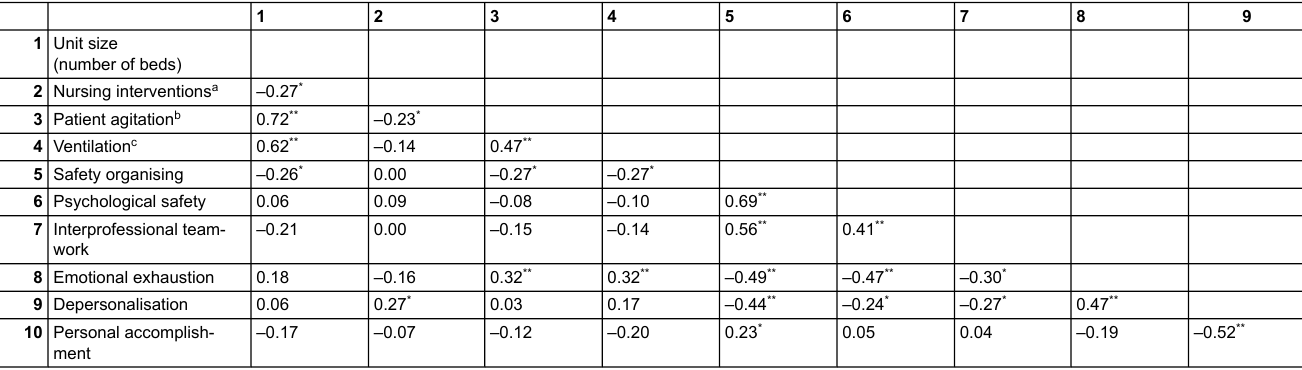
Table S2: Unit-level Pearson correlations between unit characteristics, and teamwork (safety organising, psychological safety, interprofessional teamwork) and burnout (emo- tional exhaustion, depersonalisation, personal